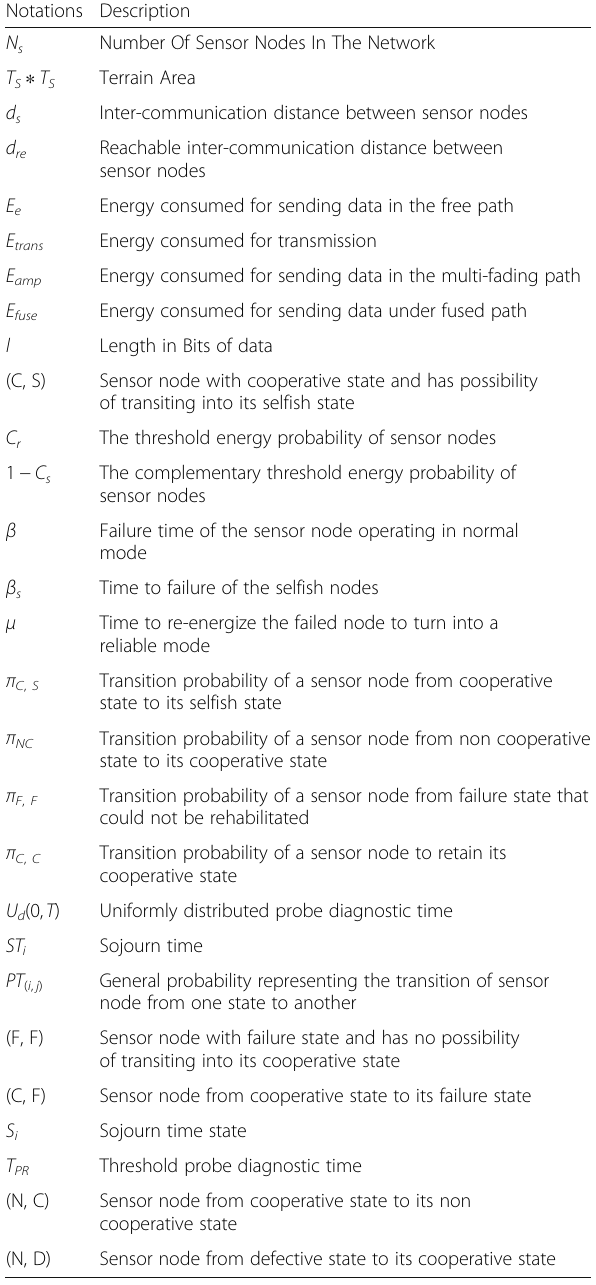
Table 1 The notations with its descriptions used in the proposed